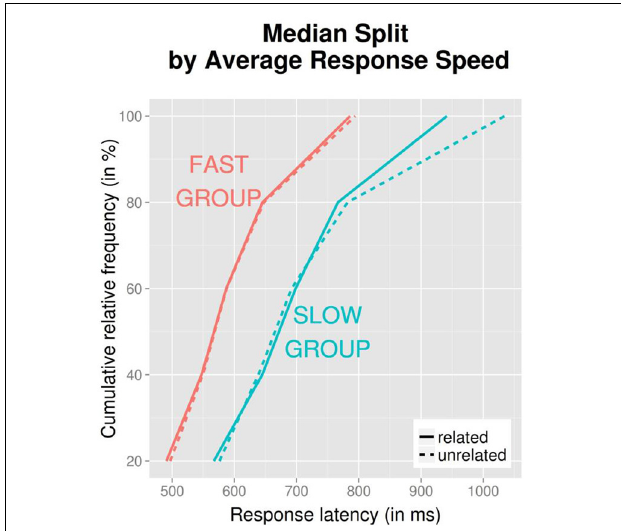
FIGURE 3 | Vincentized cumulative distribution curves for masked distractor presentation and categorically related condition, by relatedness (related vs. unrelated) and median split of participants (fast vs. slow) based on average latency in the “masked”